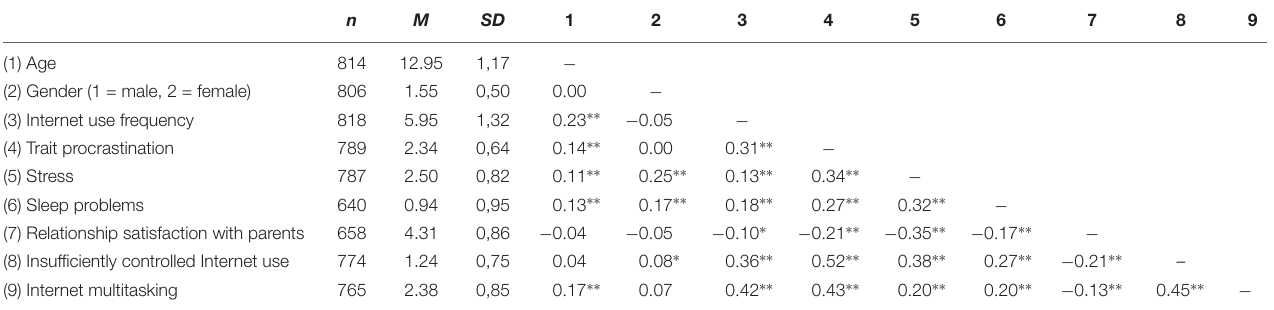
TABLE 1 | Means, standard deviations, and zero-order correlations of study variables. n M